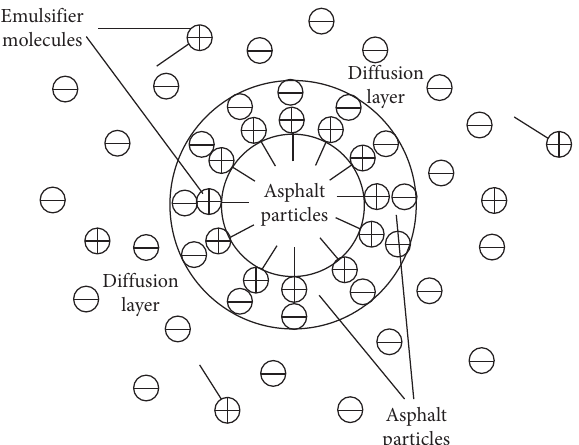
Figure 1: Schematic diagram of the electric double layer of the asphalt particle [26].